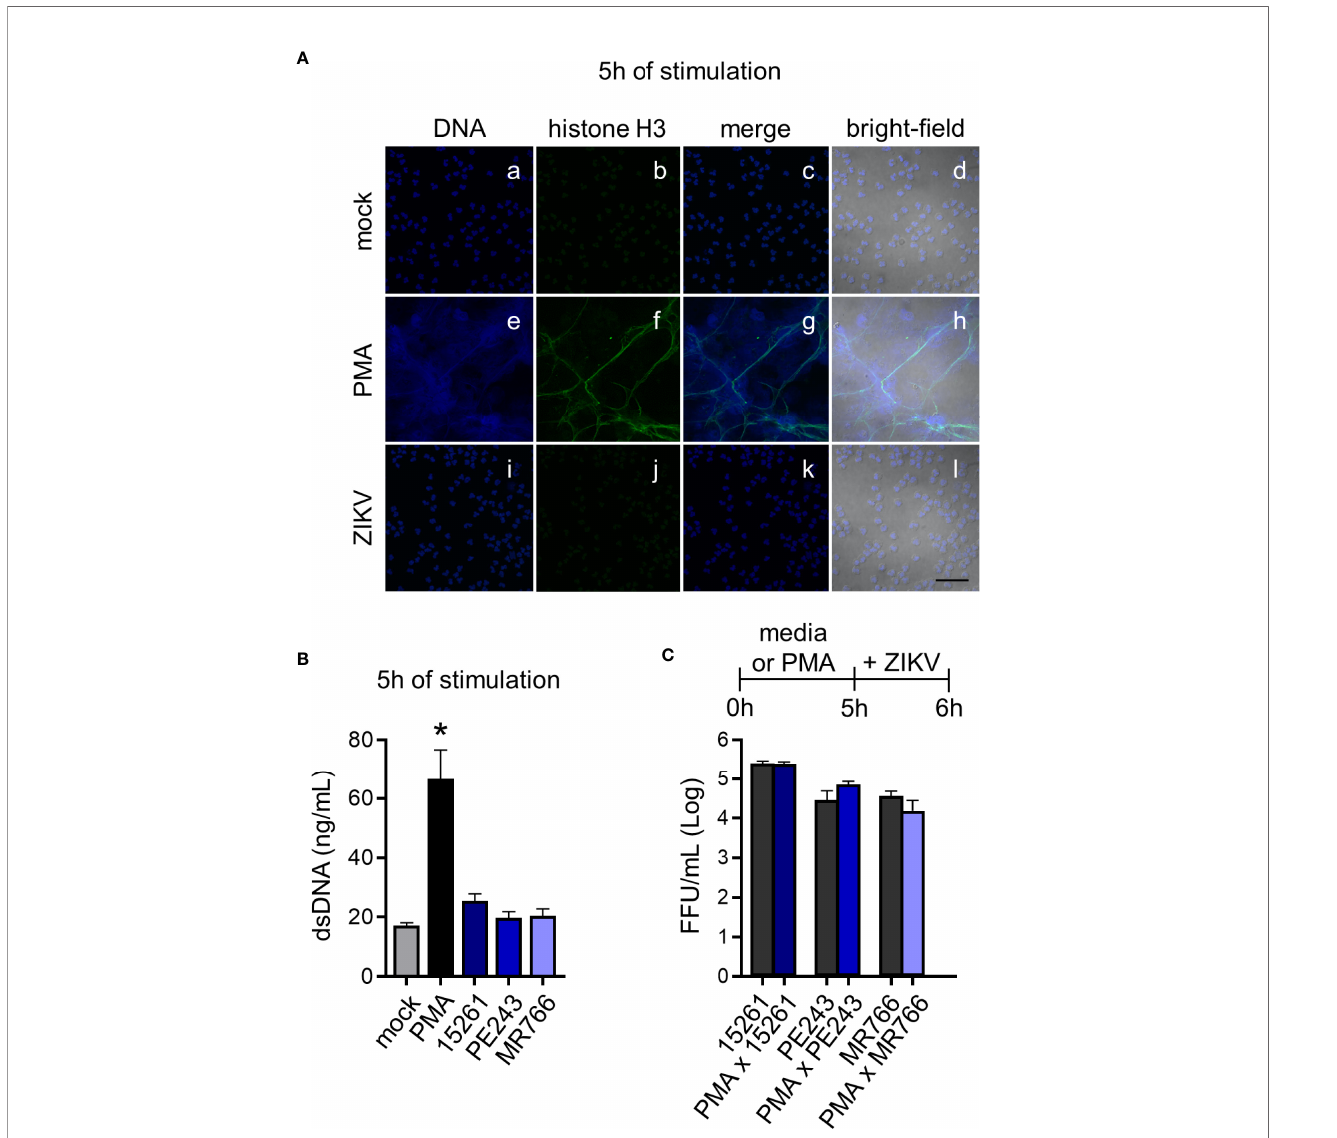
FIGURE 3 | ZIKV does not induce NETs and is not captured by the DNA trap. (A) Immunostaining of neutrophils DNA (Vybrant DyeCycle Violet, blue) and acetyl- histone H3 (green) after 5 hours of stimulation with mock (a-d), PMA (160 nM) (e-h), or ZIKV PE243 (1 MOI) (i-l). ZIKV PE243 was chosen as the representative of the ZIKV strains ’ effects. Merge of these stains and the bright- fi eld colocalization are also shown (bar = 50 µm, magni fi cation = 60x). One representative of three independent experiments is shown. (B) Free double-stranded DNA (dsDNA) in neutrophil culture supernatant after 5 hours of stimulation with mock, PMA, or ZIKV strains (1 MOI). (C) ZIKV strain loads on neutrophil culture supernatant after 1 hour in the presence or absence of NETs induced by PMA stimulation during 5 hours. Bars indicate SEM. Two-three independent experiments are shown (n = 6 – 9). The asterisk (*) denotes the statistical difference between mock and